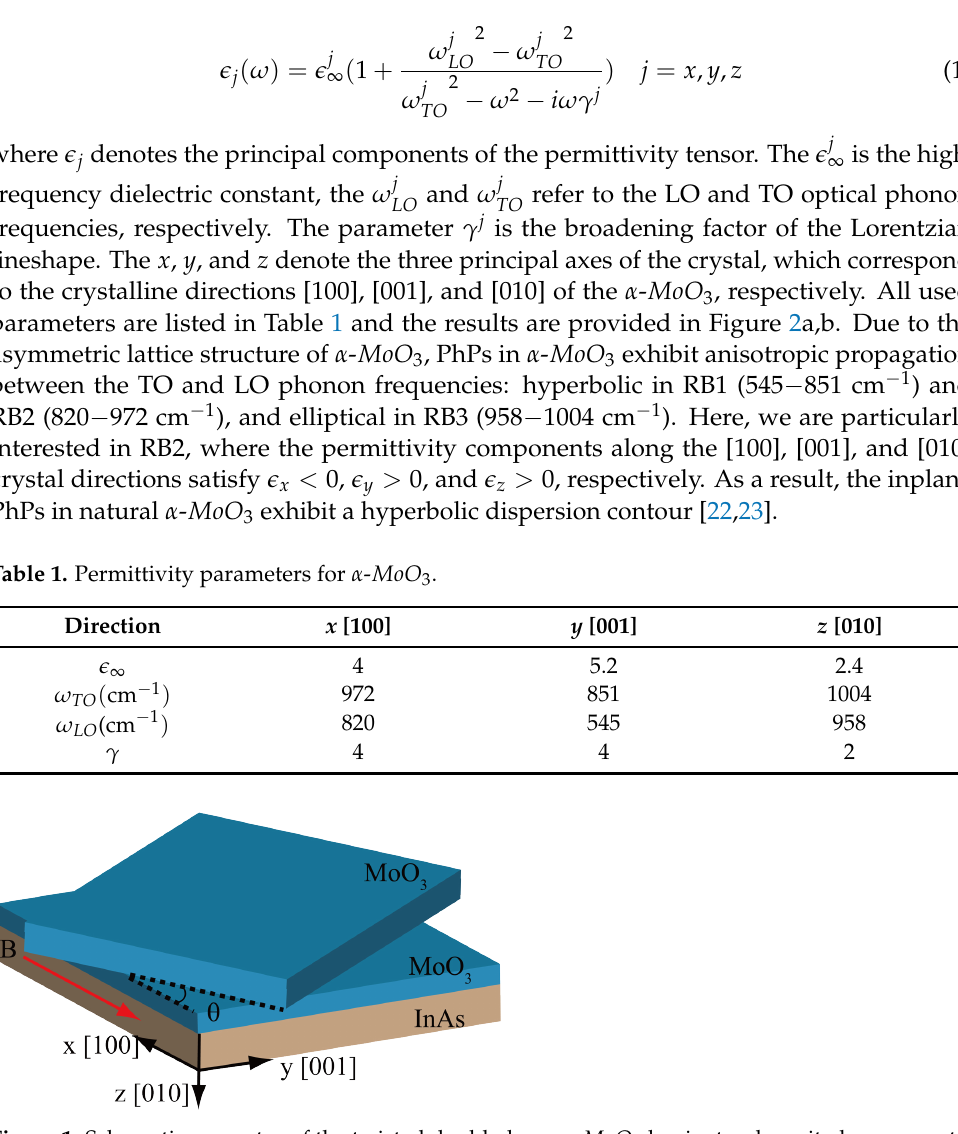
Figure 1. Schematic geometry of the twisted double-layer α - MoO 3 laminates deposited on magneto- optic InAs